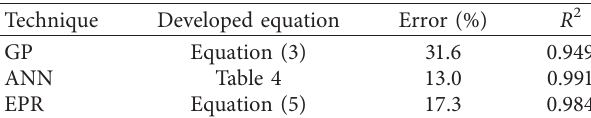
Table 6: Accuracies of the developed models for N ′ q .